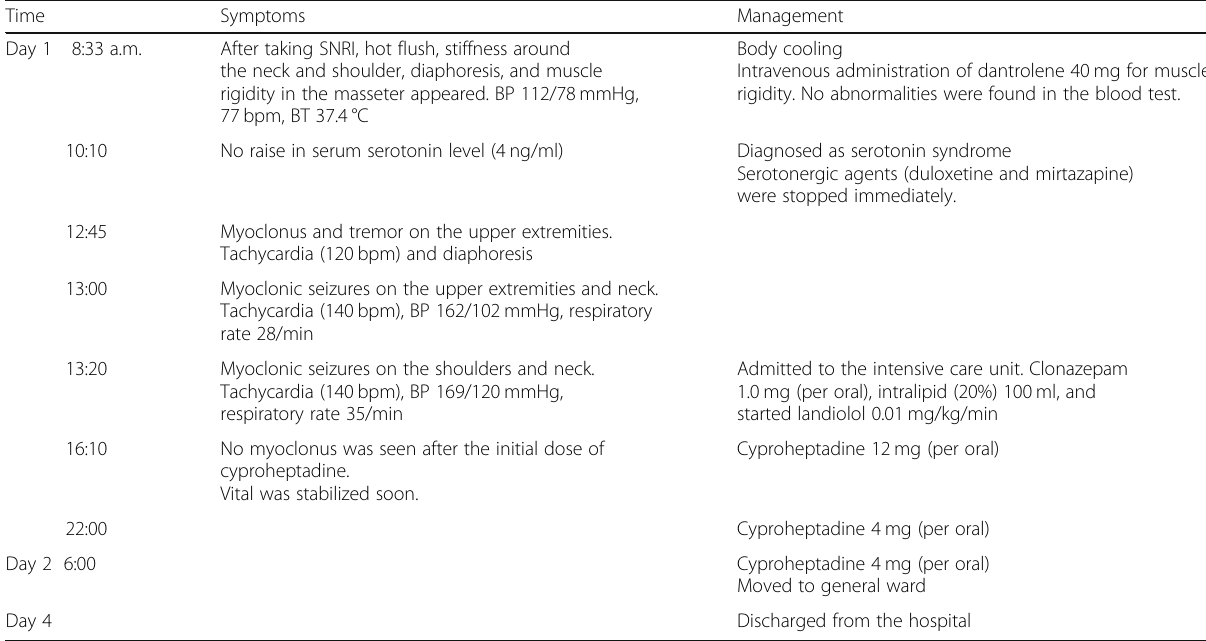
Table 2 Timeline of development of symptoms and management Time Symptoms